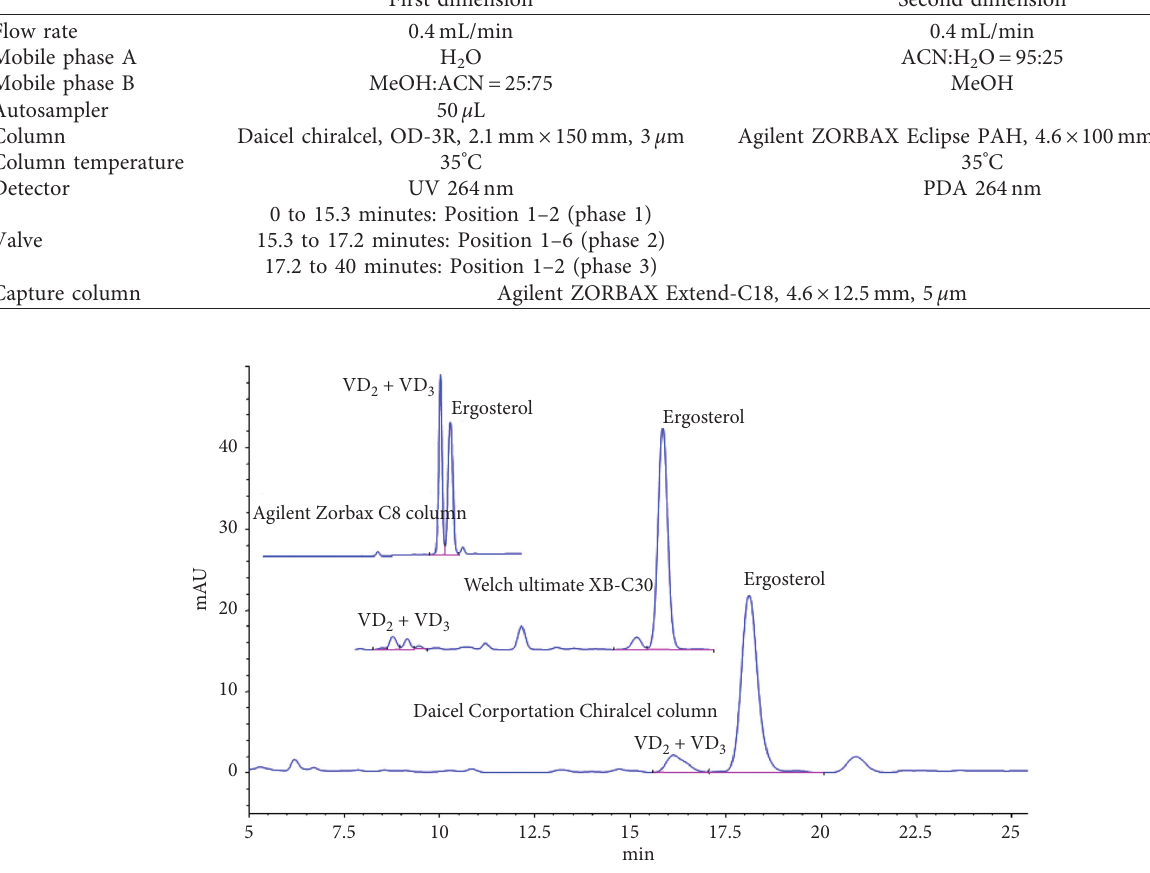
Figure 1: Separation of one-dimensional chromatogram by different columns in Lentinus edodes (spiking levels 100 μ g/100g for VD and ergosterol).